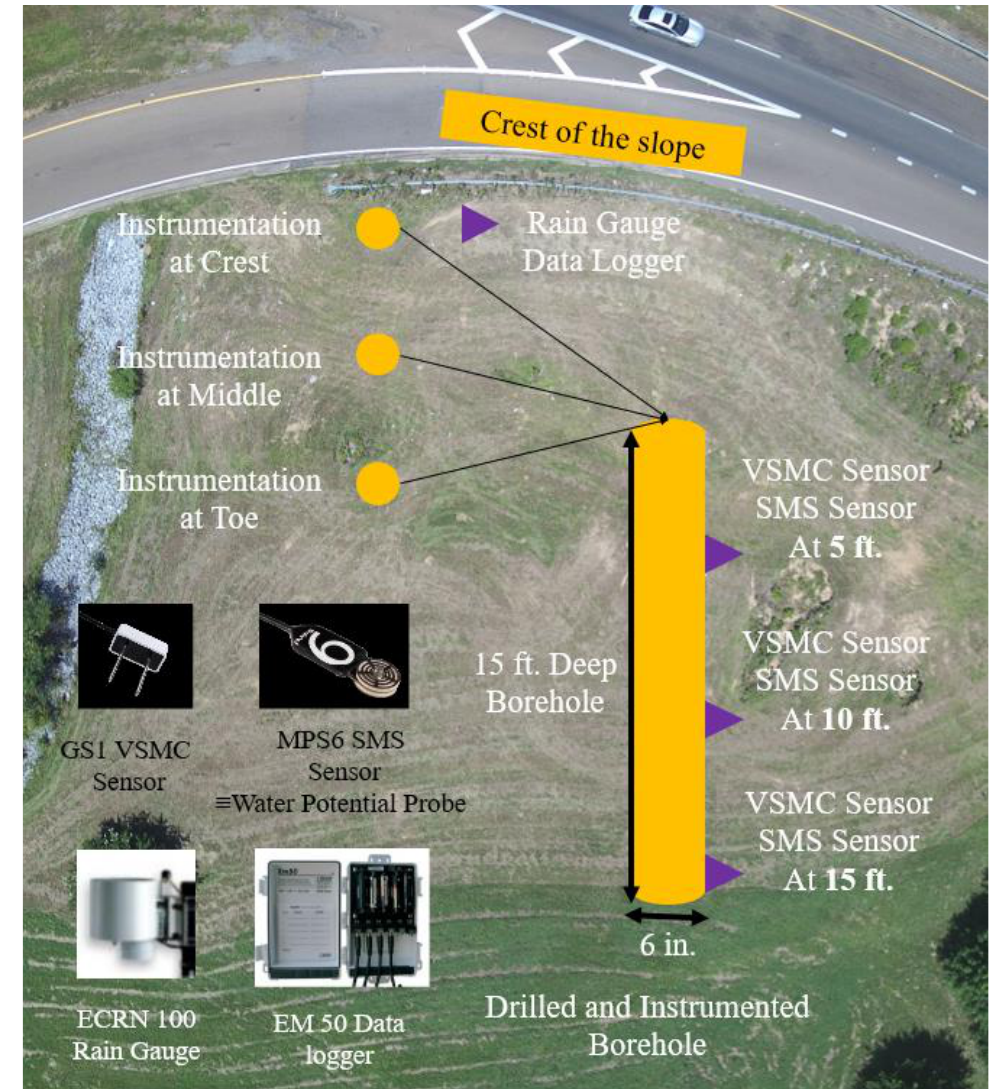
Figure 5. Typical Instrumentation locations on a HWS (Drone Image-top view) (1 ′ = 1 ft = 0.305